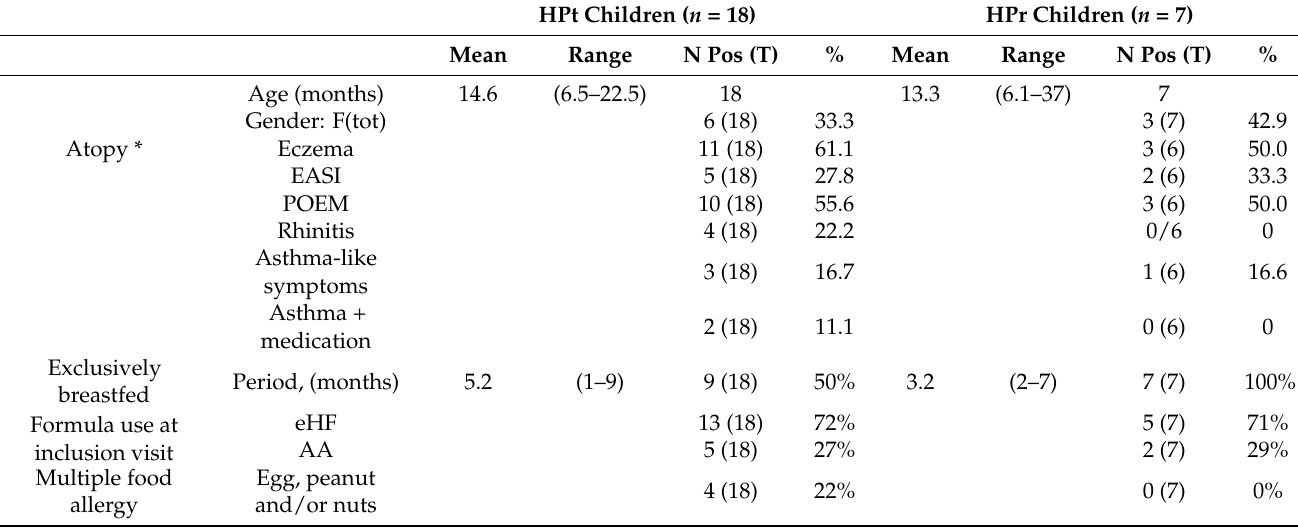
Table 2. Baseline characteristics of the HP-tolerant (HPt) and HP-reactive (HPr)